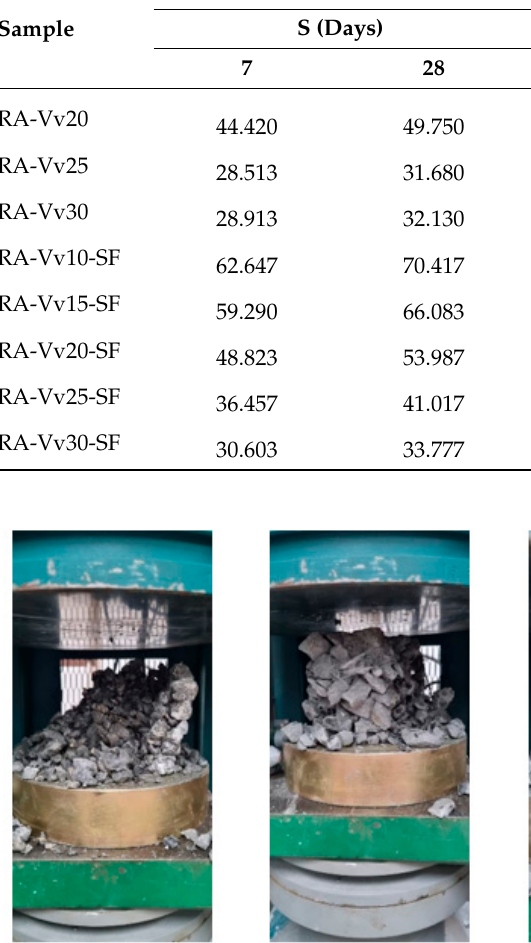
Figure 4. Temperature measurement scheme.